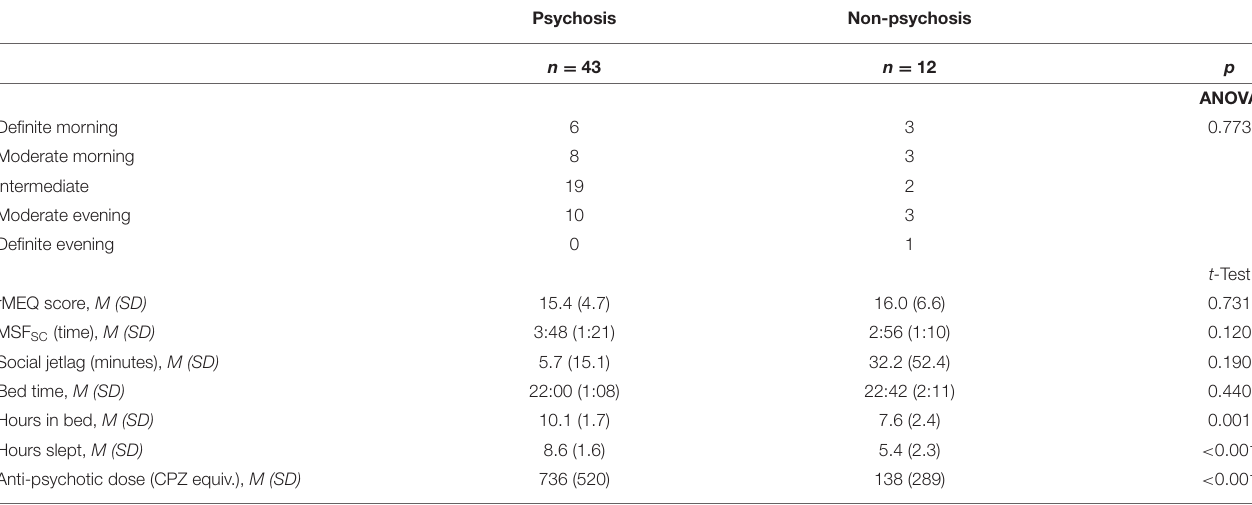
TABLE 4 | Differences in chronotype, anti-psychotic medication, hours slept, hours spent in bed, and rMEQ scores for psychosis and non-psychosis groups.